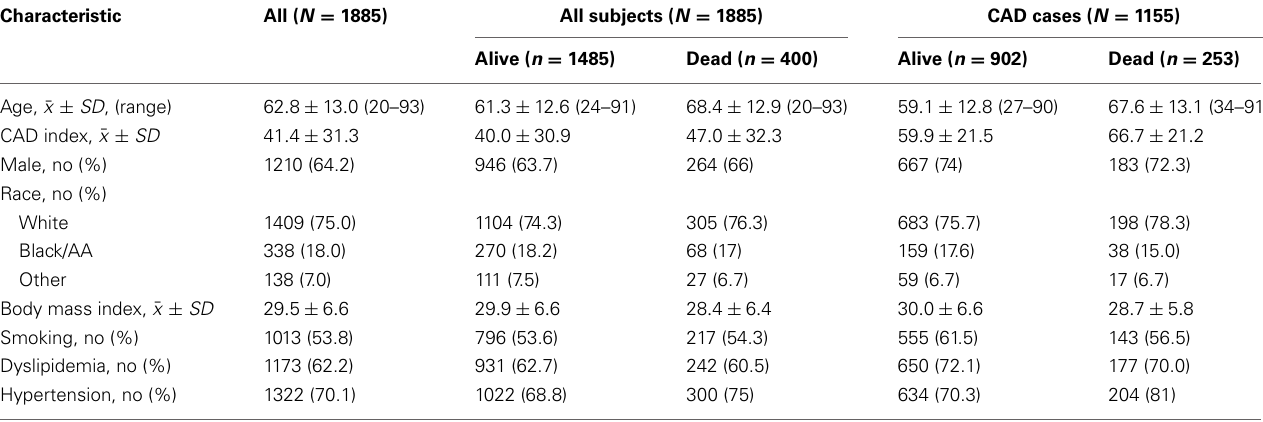
Table 3 | CATHGEN demographic and clinical characteristics.